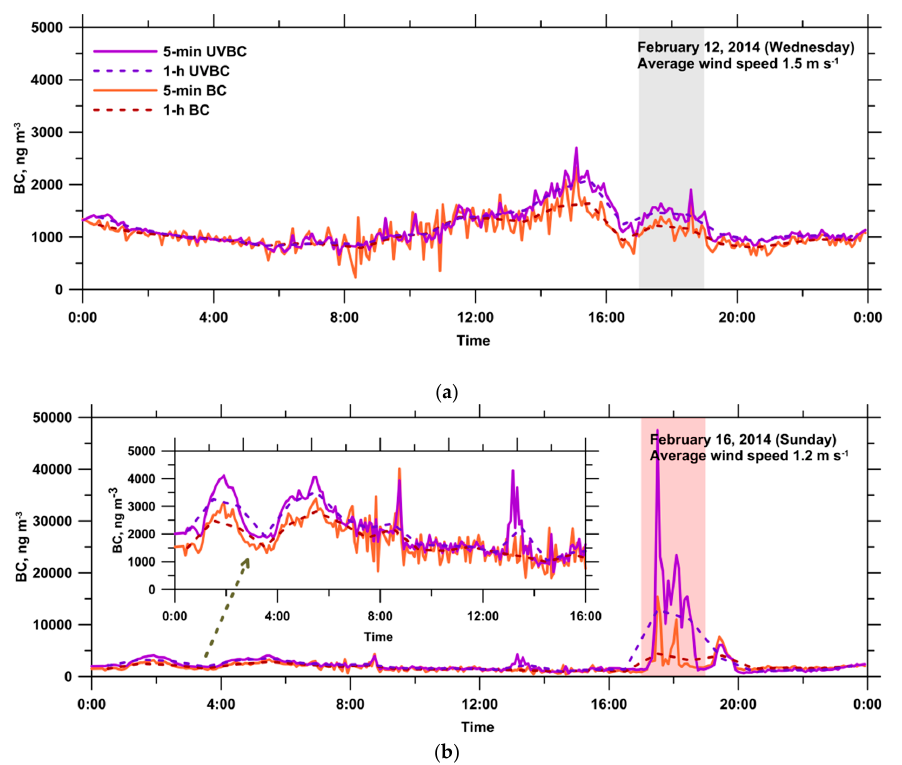
Figure 5. Diurnal variations of 5-min and 1-h UVBC and BC concentrations at the monitoring site on ( a ) the reference day; and ( b ) the event day.